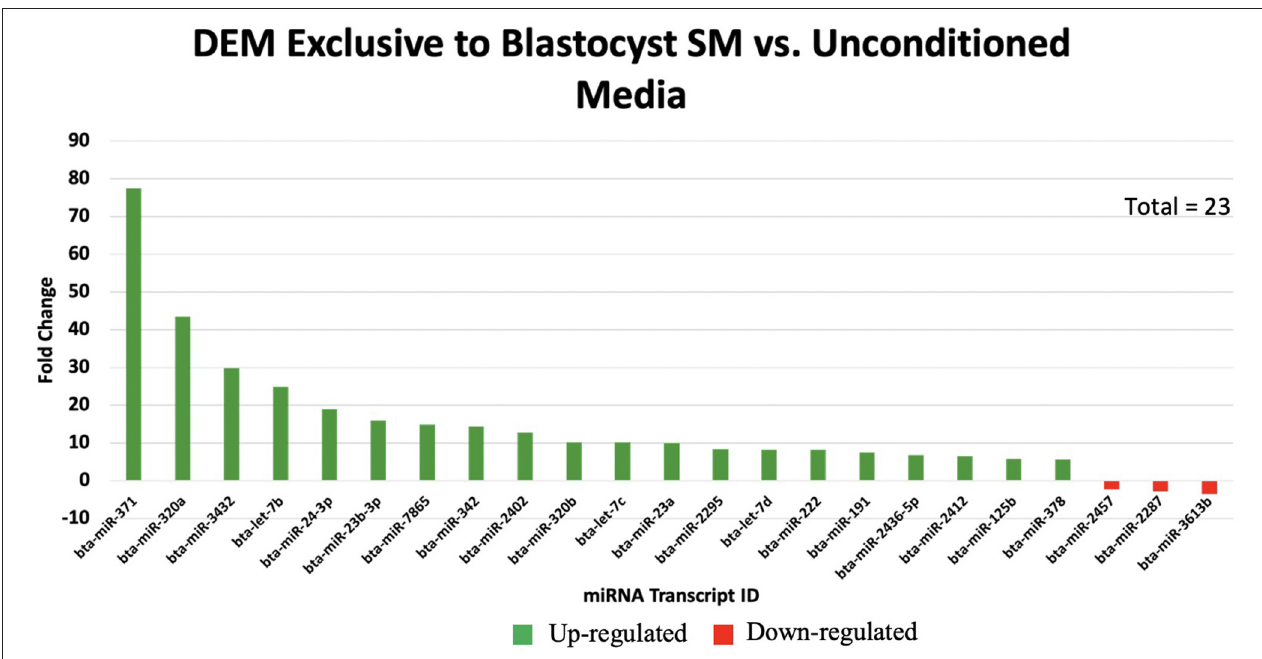
to another. One miRNA was consistently downregulated (bta-miR-450b) in comparison to unconditioned media and the degree of downregulation was consistent across all 3